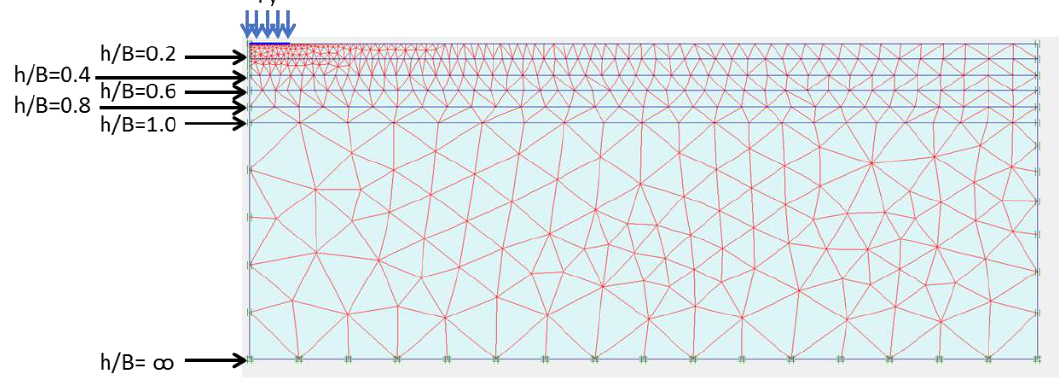
Figure 6. A summary of the range of input information vs. soil type, ( a ) Dilation angle, ( b ) Unit